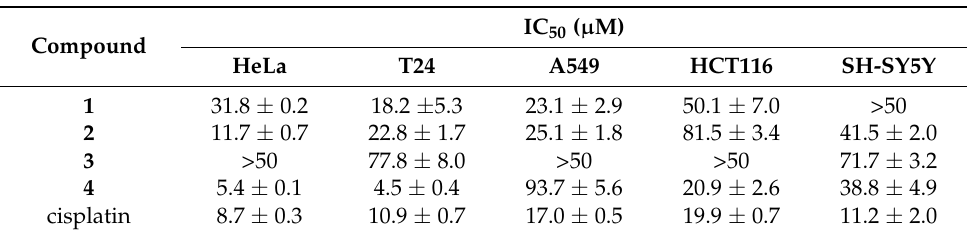
Table 2. Cytotoxicity of compounds 1 – 4 .